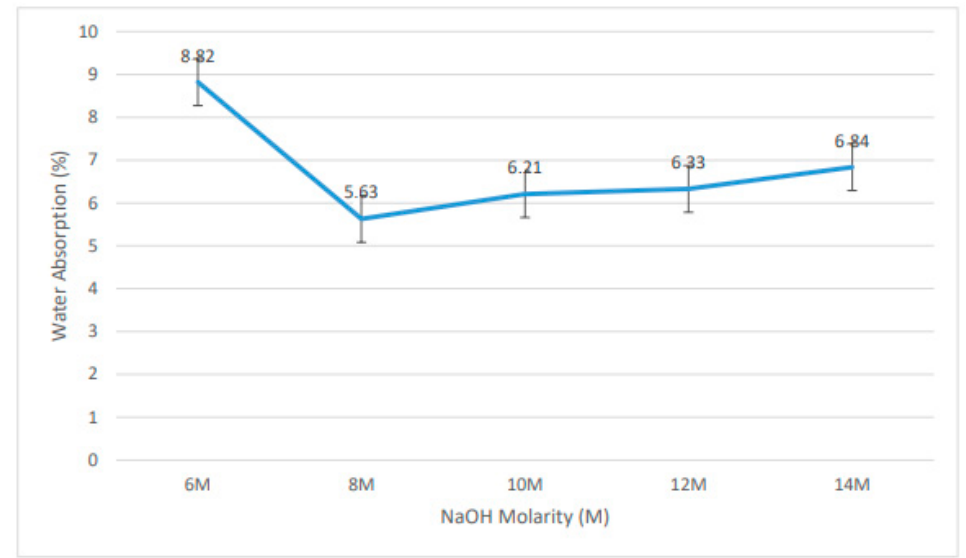
Figure 4. Rate of water absorption for fly ash/dolomite geopolymer.